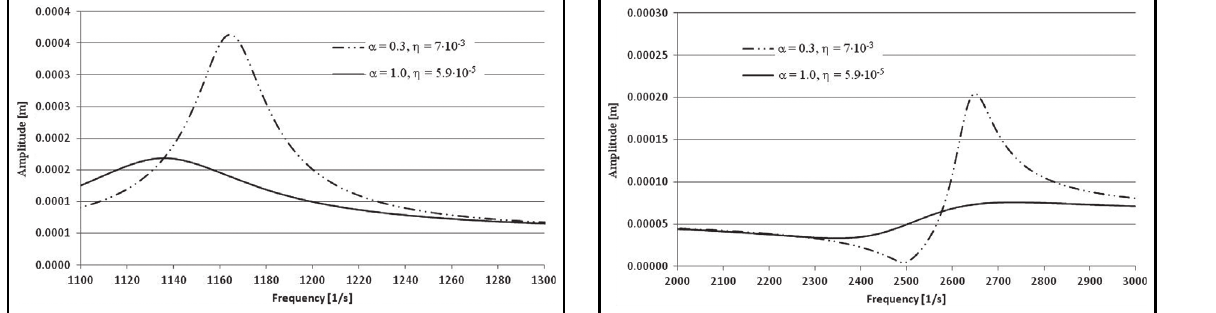
Fig. 13. Comparison of amplitude-frequency characteristics for α = 0.3 η = 7 · 10 − 3 and α = 1.0 η = 5.9 · 10 − 3 – 3-th